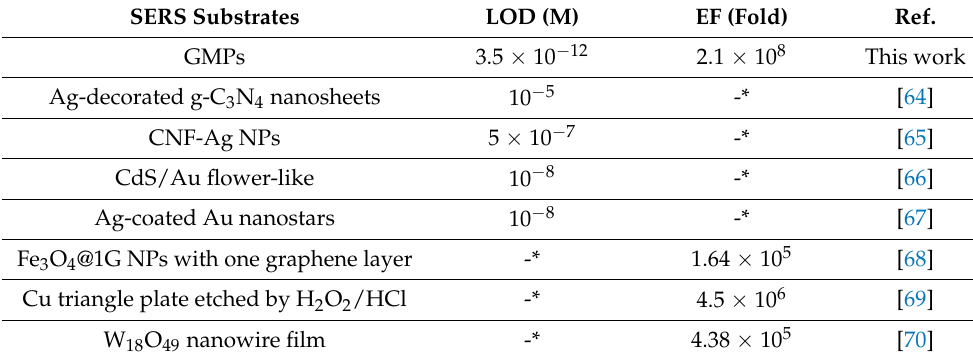
Table 2. The other results of RhB detection using SERS. SERS